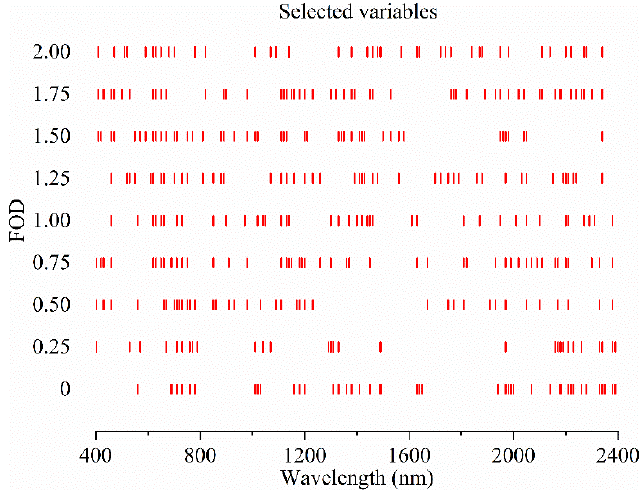
Figure 10. The distributions of spectral variables selected by genetic algorithm (GA) method at different derivative orders.